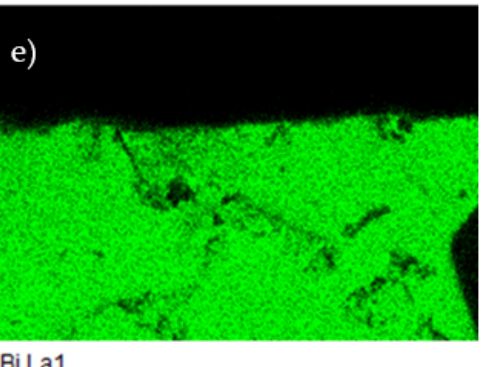
Figure 15. Planar distribution of Ti, Si, Ag, and Bi elements in the boundary of Si/Bi11Ag1.5Ti joint. ( a ) joint microstructure ( b ) Ti ( c ) Si ( d ) Ag ( e ) Bi.